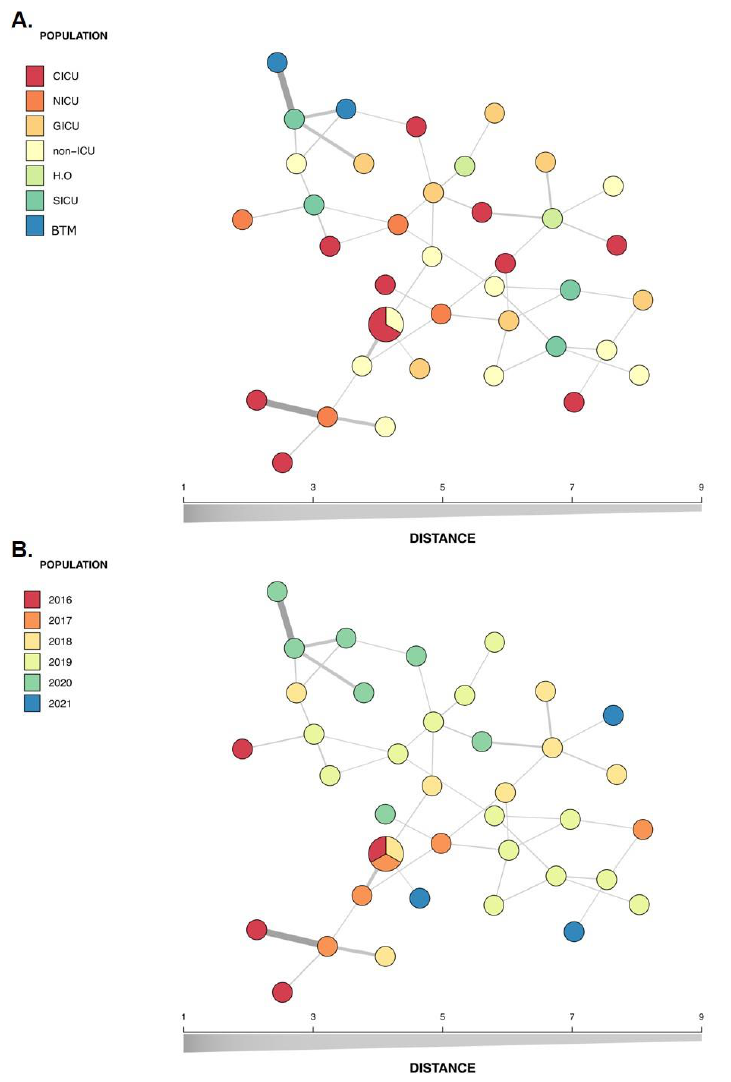
Figure 5. Minimum spanning tree of the relationship between the 38 genotypes among the 40 isolates of C. parapsilosis sensu stricto isolated from the bloodstream of infected patients over a 5-year period in a pediatric tertiary hospital. Each circle represents a unique genotype, while circle size corresponds to the number of isolates of the specific genotype and the color of the isolates represent the hospital setting ( A ) or year of isolation ( B ). CICU, cardiac intensive care unit; ICU, intensive care unit; NICU, neonatal intensive care unit; GICU, general intensive care unit; SICU, surgical intensive care unit; HO, hematology-oncology; BMT, bone marrow transplant.